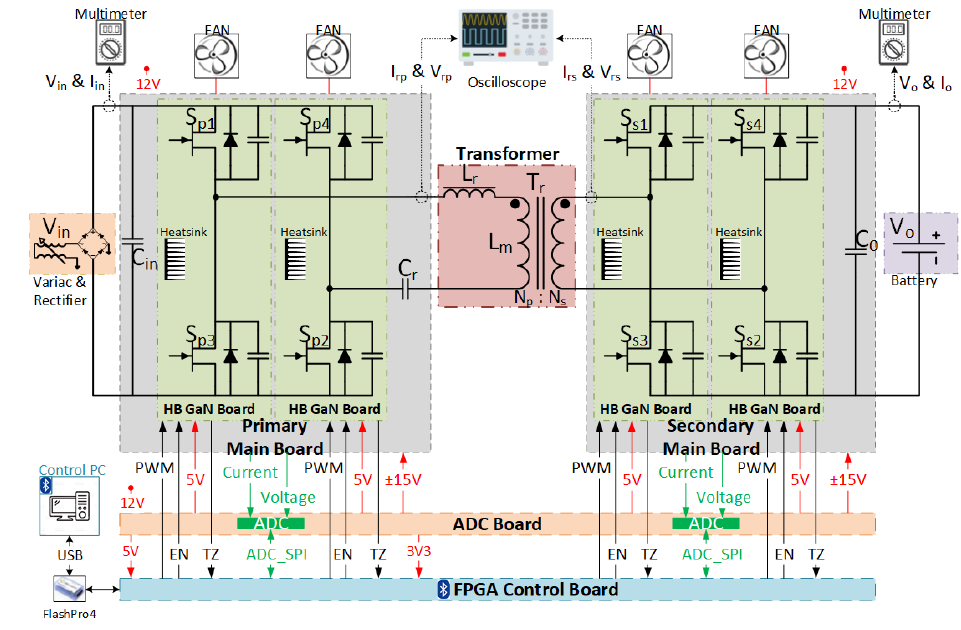
Figure 10. Block diagrams of the experimental